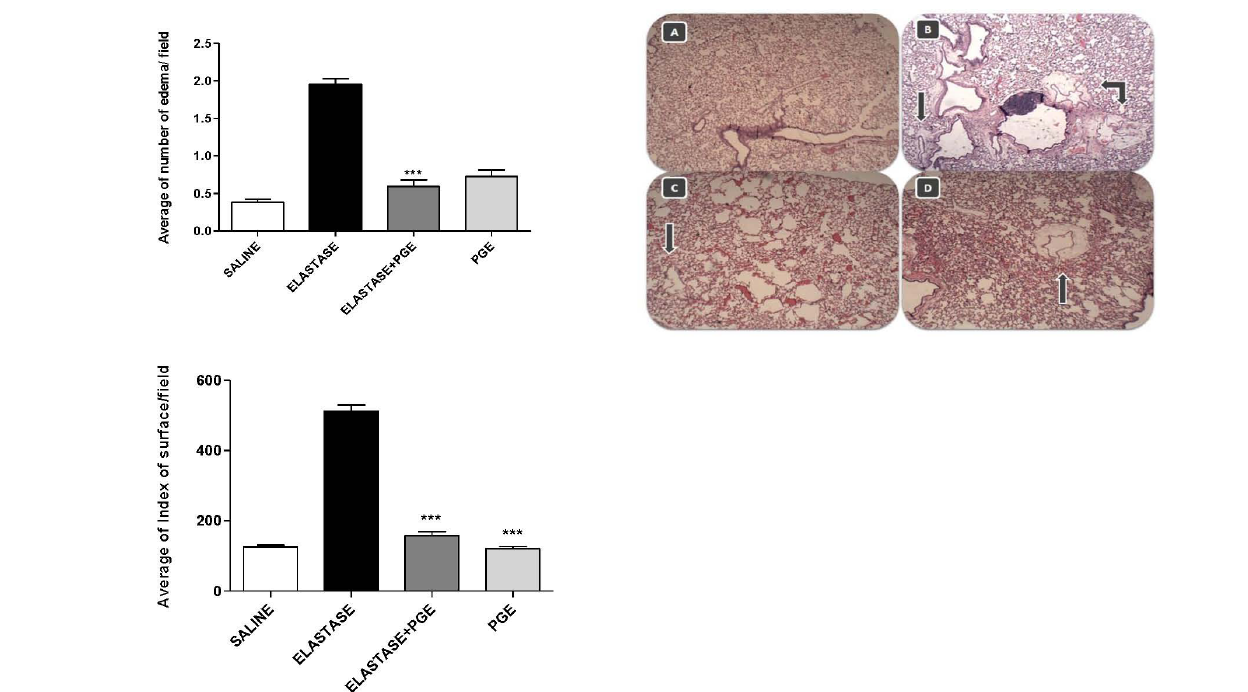
FIGURE 2 – T he number and Index of surface of lung oedemas Significance pair to pair comparison are showed **: p for trend ≤